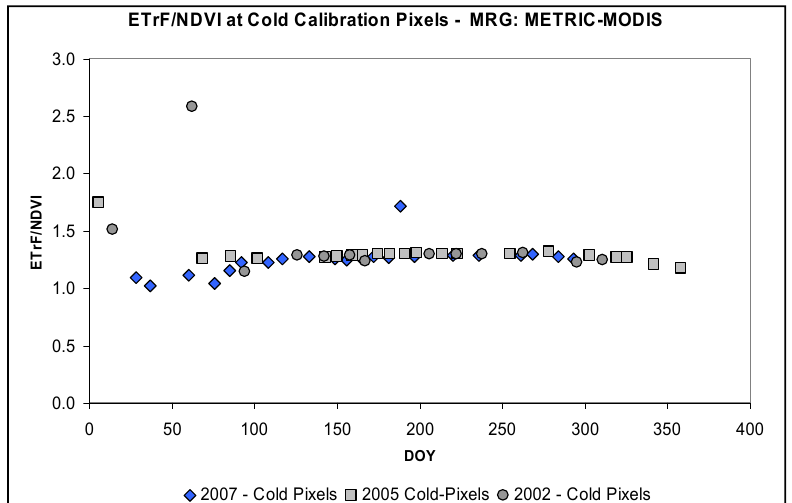
F/NDVI for the cold pixel calibration condition for Figure 7. Comparison of ET r application of METRIC to the MRG region during years 2002, 2005 and 2007. M ETrF/NDVI at Cold Calibration Pixels - MRG: